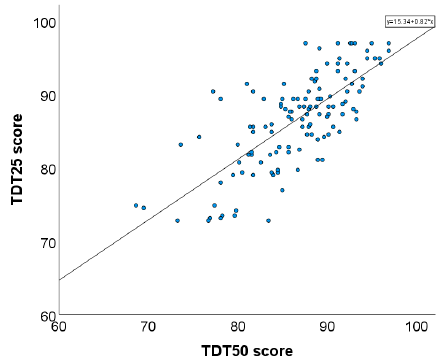
Figure 3. Scatterplot of Tactile Discrimination Test (TDT) scores TDT25 compared to TDT50 ( n = 63) for the combined dominant and non-dominant hand in neurologically healthy pooled samples.